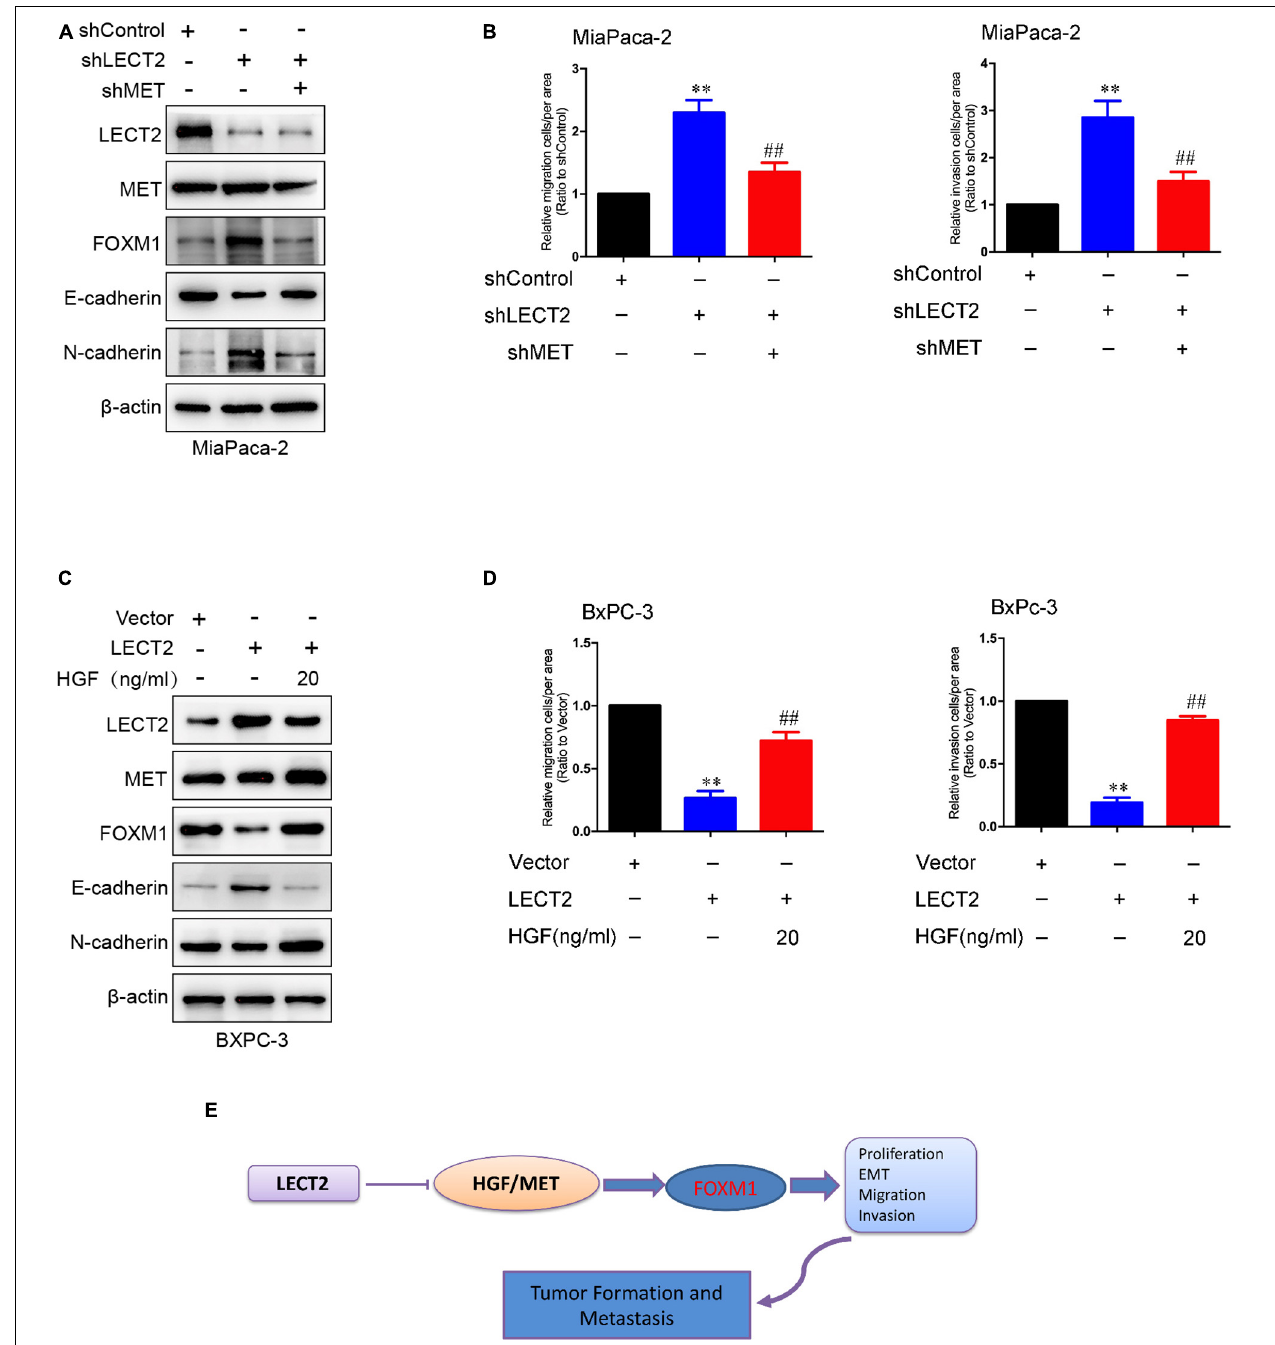
FIGURE 8 | HGF/MET is involved in the regulation of FOXM1 by LECT2. (A) Immunoblotting analysis of LECT2, MET, FOXM1, E-cadherin, and N-cadherin protein levels in MiaPaca-2 cells transfected with shControl, shLECT2, and shMET. (B) Migration (left) and invasion (right) of MiaPaca-2 cells described in (A) . (C) Immunoblotting analysis of LECT2, MET, FOXM1, E-cadherin, and N-cadherin protein levels in BxPC-3 cells transfected with Control, LECT2, and/or HGF vectors. (D) Migration (left) and invasion (right) of BxPC-3 cells described in (C) . (E) Schematic model illustrating the biological processes regulated by LECT2 in PDAC. ** p < 0 . 01 and ## p < 0 .